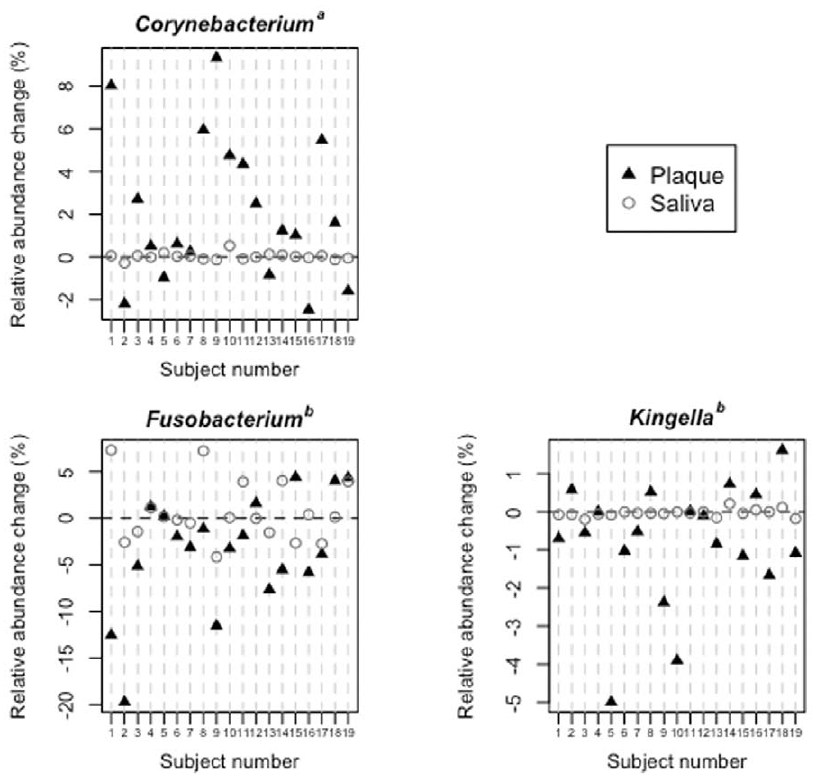
Figure 5. Relative abundance changes of three bacterial genera in the supragingival plaque microbiota and salivary bacterial population. a Significantly increased in the plaque microbiota after periodontal therapy. b Significantly decreased in the plaque microbiota after periodontal therapy.